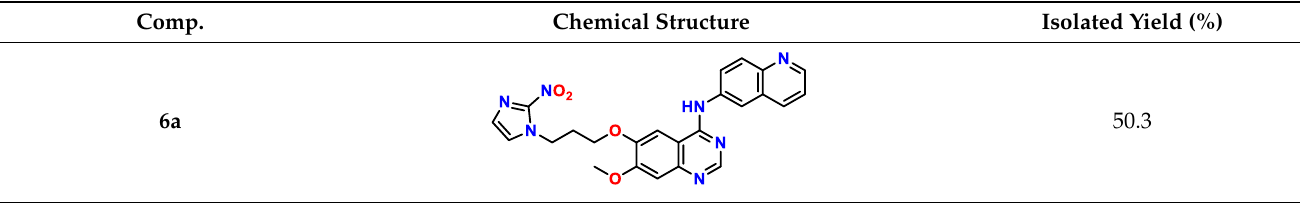
Table 1. Chemical structures and yields of the newly synthesized lapatinib derivatives 6a – l . Comp.